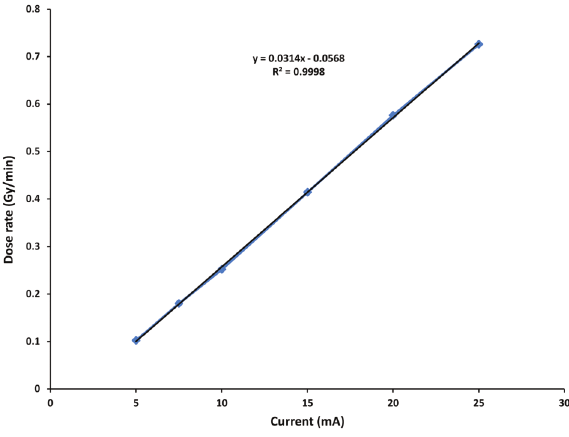
Figure 9. Experimental scheme for the irradiator radiometric survey. A , Front; B , right; C , back; and D ,